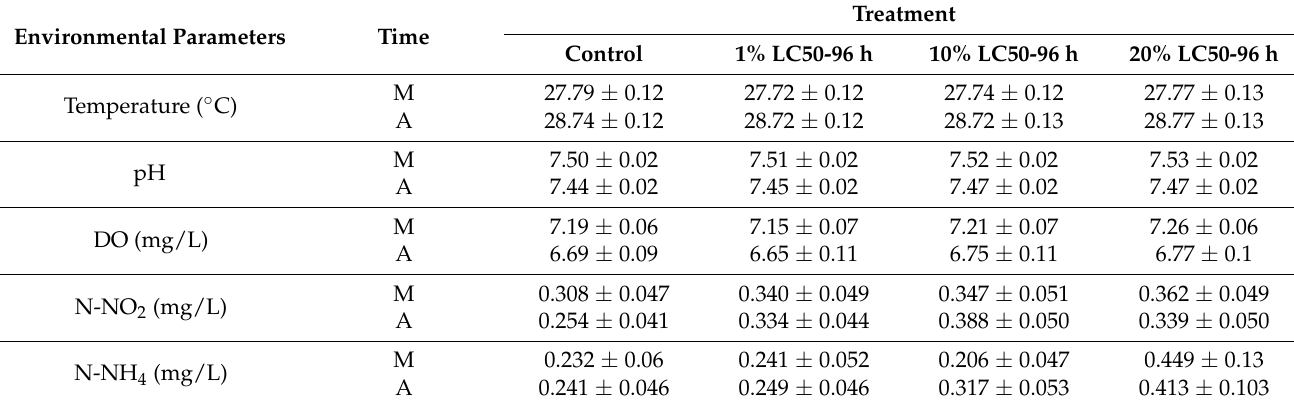
Table 4. Environmental conditions of experiment tanks during the growth performance experiment.